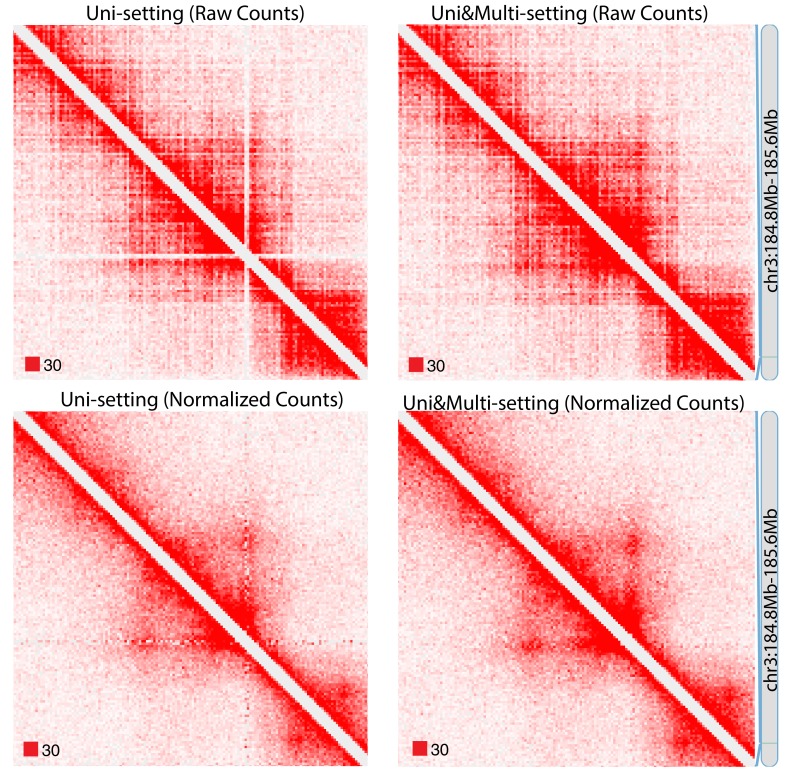
Raw and normalized contact matrices of GM12878 under Uni-setting and Uni&Multi-setting on chromosome 3.